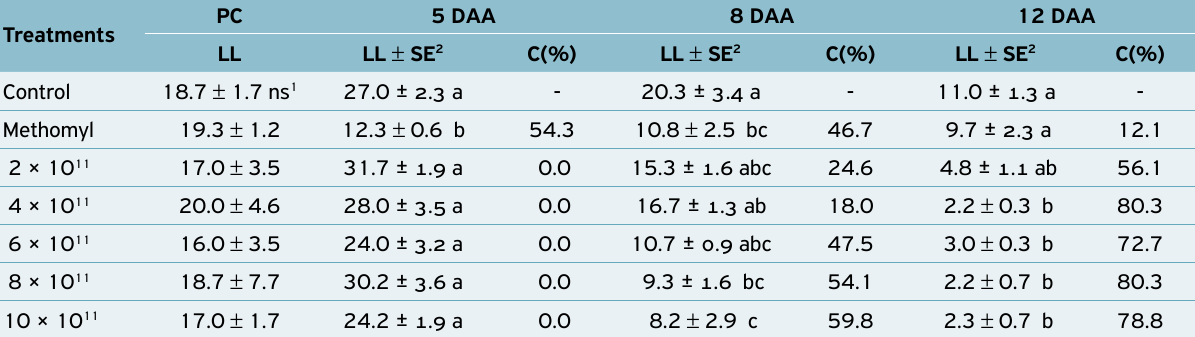
1 ns = not significant in the variance analysis by the F test, at 5% probability; 2 mean followed by the same letter in the column do not differ statistically from each other by the Tukey’s test, at 5%